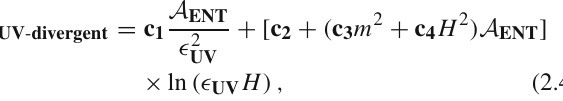
ary S 2 at the equator. For simplicity we can also use hyperbolic slices where the interior of the S 3 mimics the role of the “left” (L) slices. Corresponding Penrose diagrams are drawn for completeness